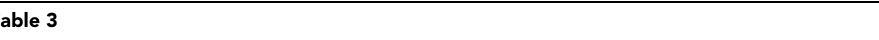
Means and Standard Deviations (SD) of Attitudes to Mental Health Indicators at Each Measurement Point Pre training Immediate after training